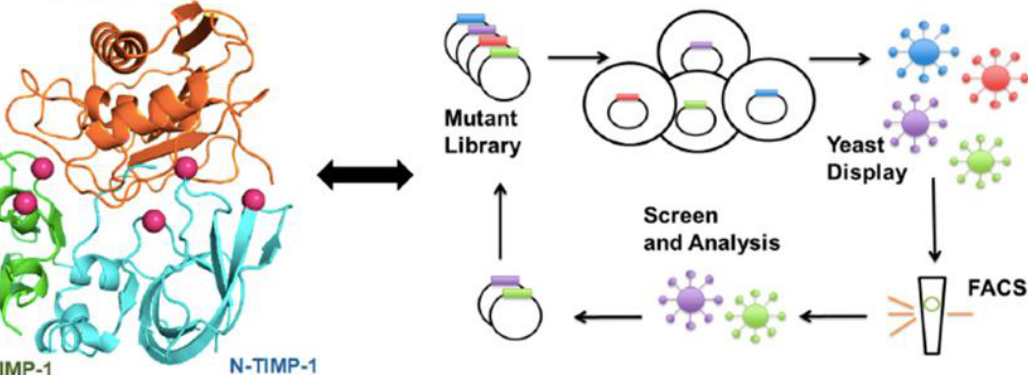
Figure 1. Engineering and designing MMPs inhibitors (from Raeeszadeh-Sarmazdeh, M.; Do, L.D.; Hritz, B.G. Metalloproteinases and Their Inhibitors: Potential for the Development of New Therapeutics. Cells 2020 , 9 , 1313. https://doi.org/10.3390/cells9051313, MDPI open access publication rules) [12].